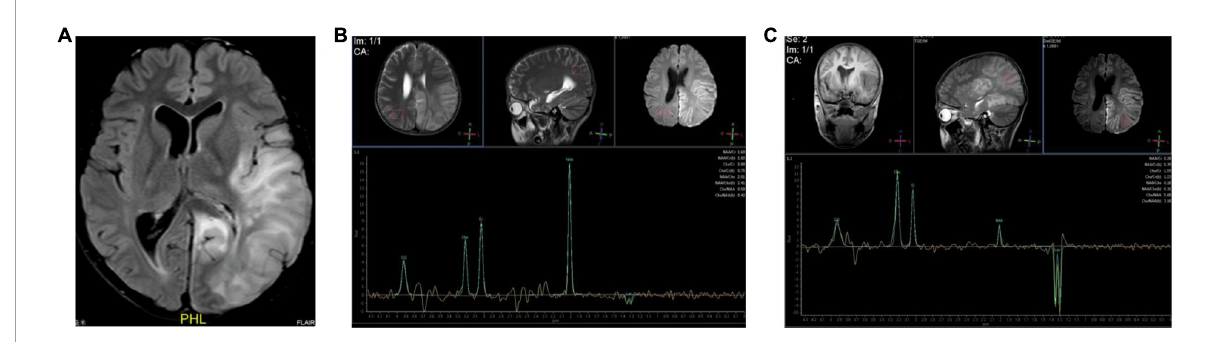
FIGURE5 Elevated lactate doublet peaks on MRS. Case 12, A 12-year-old boy with MELAS. (A) Transverse FLAIR images showed cortical swelling in the left temporoparietal occipital lobe. (B,C) MRS showed elevated lactate doublet peaks in both acutely affected and unaffected regions; however, it was more obvious on the left.